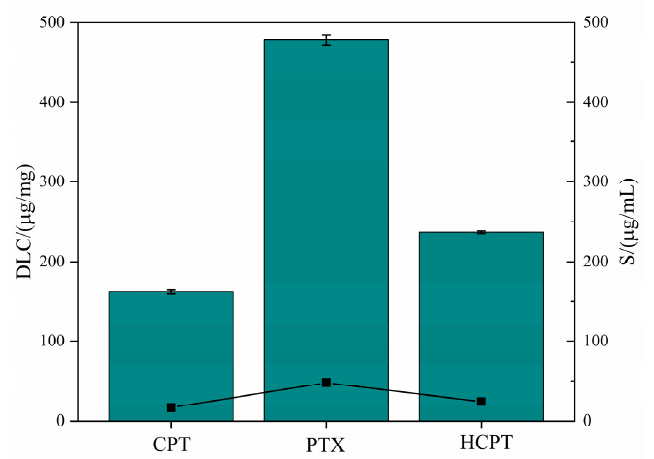
Figure 7. Drug loading and solubility of MOF@P for HCPT, CPT, and PTX.